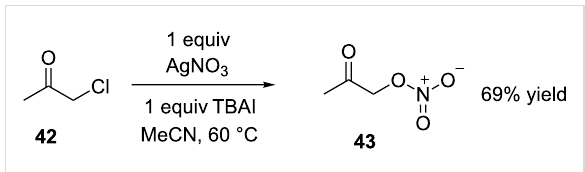
Scheme 6: Silver nitrate mediated synthesis of 2-oxopropyl nitrate 43